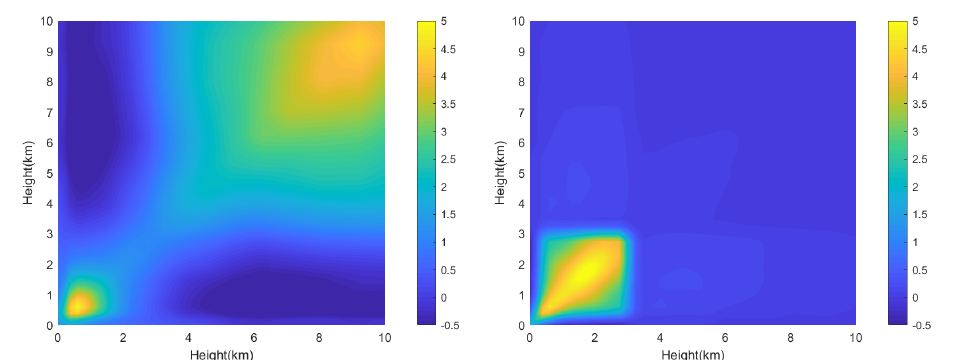
Figure 2. Background error covariance matrices of ( left ) temperature ( K ) and ( right ) water vapor density (g/m 3